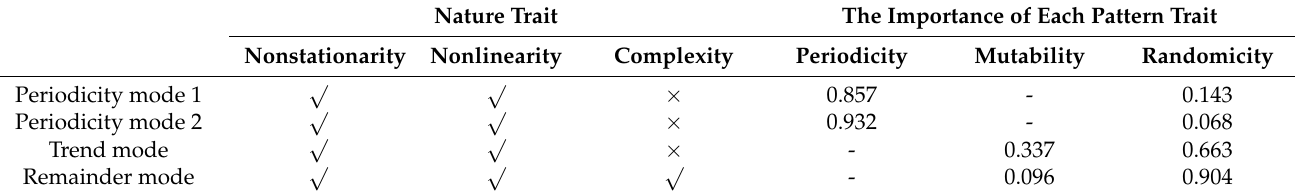
Table 3. Data trait testing of each mode. Nature Trait